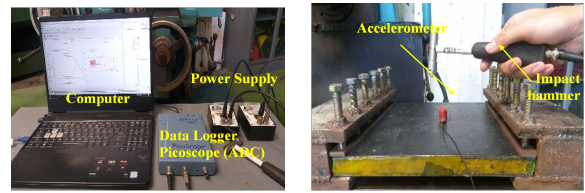
Figure 4: Experimental vibration test setup.